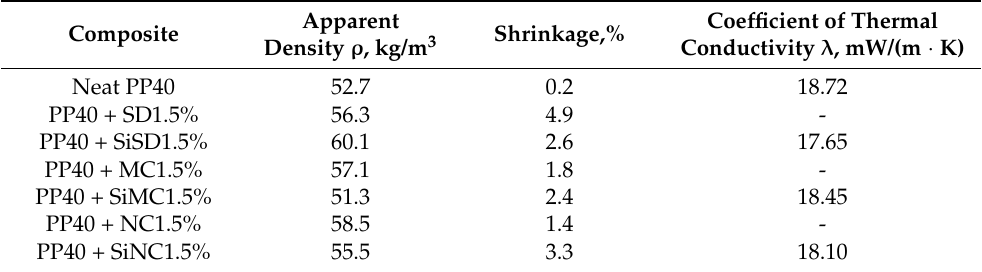
Table 2. Apparent density, shrinkage, and coefficient of thermal conductivity of PP40 composites with 1.5% filler concentration and neat PP40.